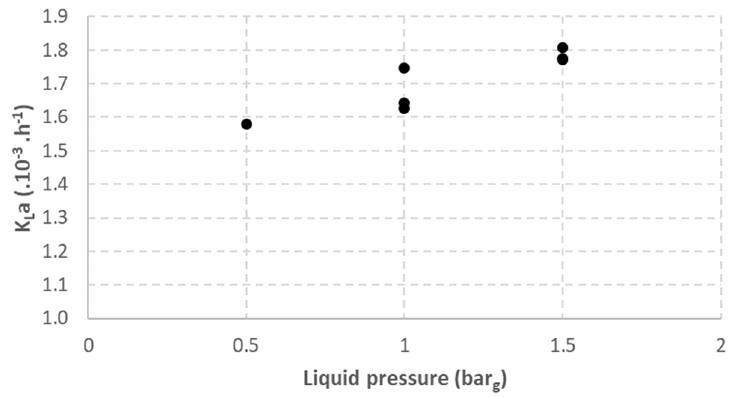
Figure 3. Impact of liquid pressure on K L a.